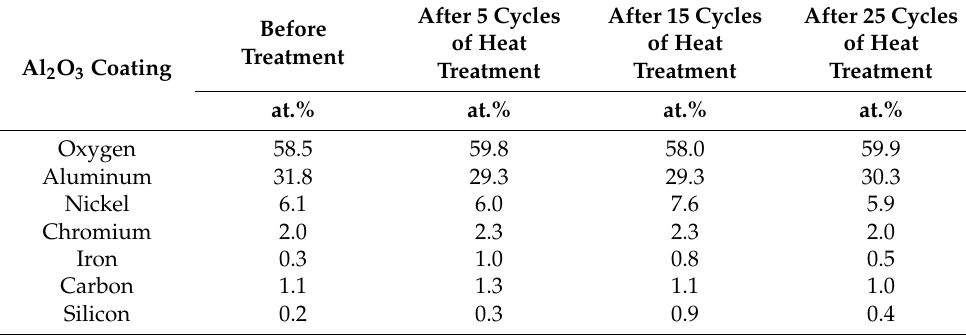
Table 4. Al 2 O 3 -13 wt.% TiO 2 coating elemental composition.